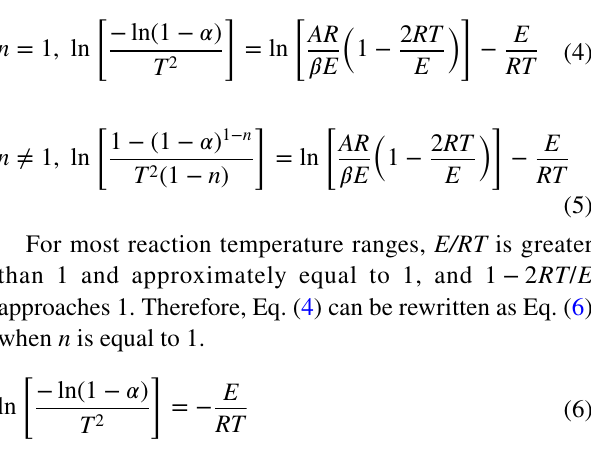
Fig. 3 TG and DTG curves of the SKS coal